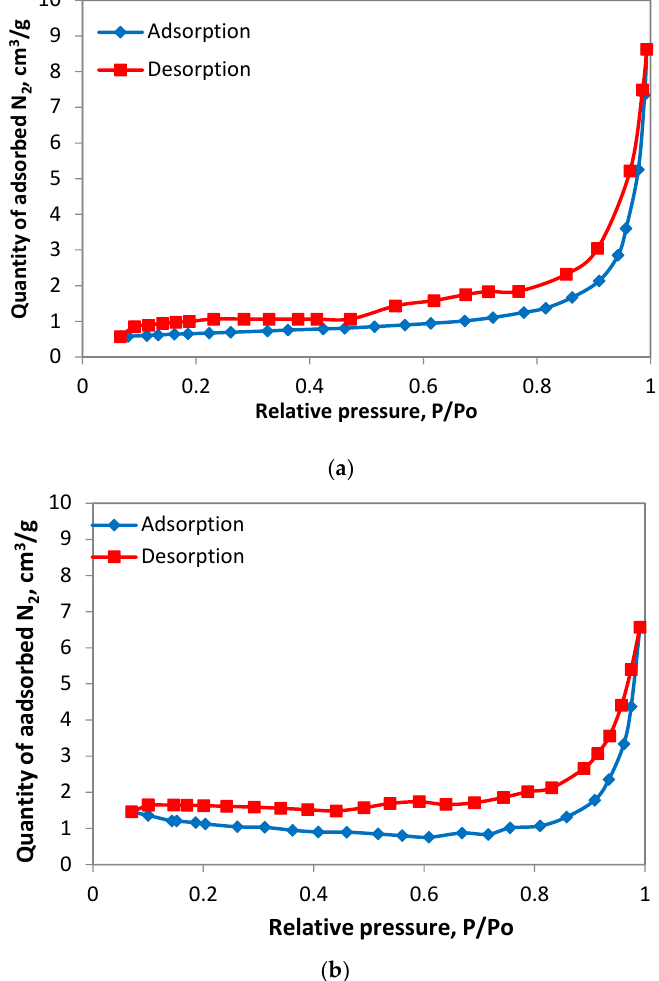
Figure 7. Hysteresis curves of the SCS materials prepared from ( a ) a not-pretreated and ( b ) a pretreated precursor solution.